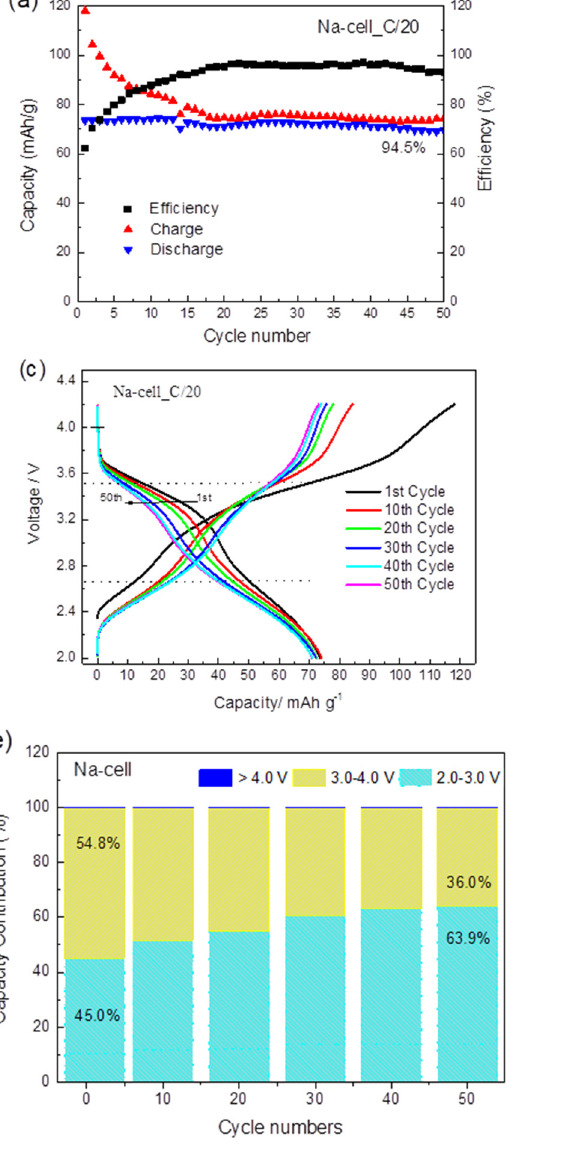
Figure 4. ( a ) Cycling performance of a Na-ion half-cell at C/20 between 2.0–4.2 V; ( b ) cycling performance of a Li-ion half-cell at C/20 between 2.3–4.3 V; ( c ) galvanostatic charge/discharge plot of a Na-ion half-cell at C/20; ( d ) galvanostatic charge/discharge plot of a Li-ion half-cell at C/20; ( e ) the corresponding discharge capacity contribution of different voltage range in a Na-ion half-cell after various cycles at the C/20; ( f ) the corresponding discharge capacity contribution of different voltage range in Li-ion half cell after various cycles at C/20. The applied current densities are 0.0061 mA/cm 2 for Na cell and 0.0056 mA/cm 2 for the Li cell.